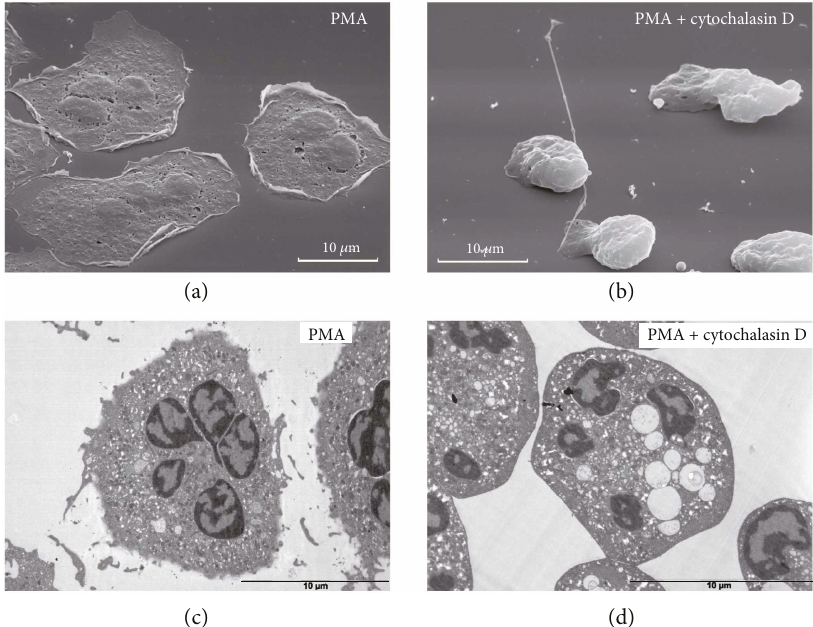
Figure 3: E ff ect of cytochalasin D on the external and internal morphology of PMA-treated neutrophils upon adhesion to fi bronectin. SEM (a, b) and TEM (c, d) images of neutrophils that were attached to fi bronectin-coated substrata over a period of 20min in the presence of 0,1 μ M PMA, taken separately (a, c) or together with 10 μ M cytochalasin D (b, d). Pictures represent typical images observed in two independent